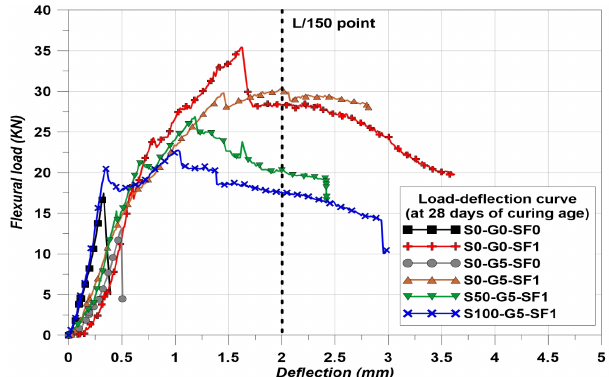
Figure 11. Flexural load–deflection curves.